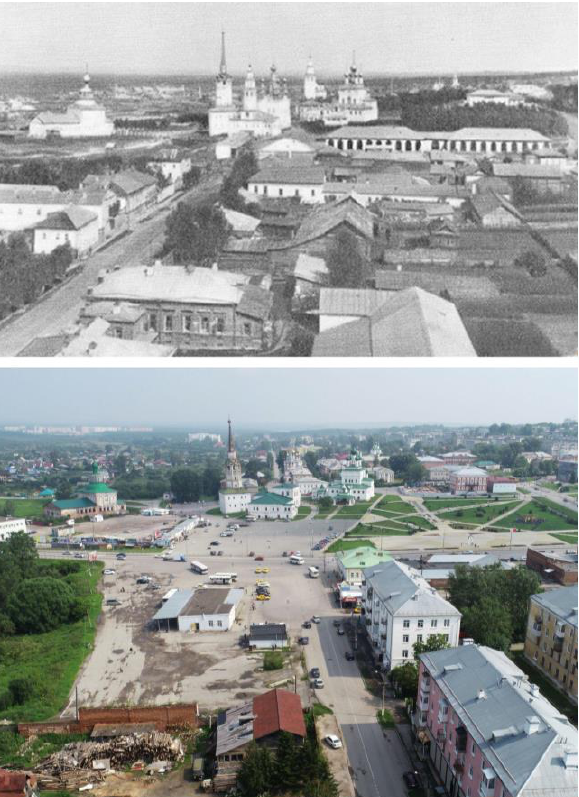
Figure 2 . Solikamsk historical center in the 19 th century and in 2019: the Heritage objects asset within the urban